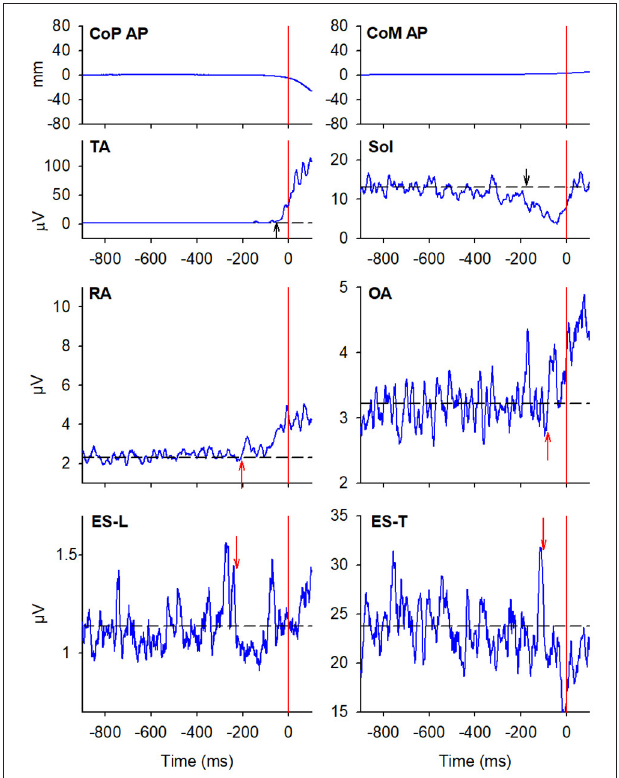
FIGURE 2 | The two uppermost plots display the AP displacements of CoP and center of mass (CoM) in a representative subject when starting gait. Vertical red lines at time 0 mark the onset of the backward CoP shift. The remaining plots show the EMG activity recorded in the prime movers Tibialis Anterior (TA) and Soleus (Sol), as well as in trunk postural muscles Rectus Abdominis (RA), Obliquus Abdominis (OA), Erector Spinae at L2 vertebra (ES-L), and Erector Spinae at T3 (ES-T) of the leading side (right). Arrows in each EMG plot mark the onset of excitation (upward arrow) or inhibition (downward arrow). Black dashed lines represent the average muscle activity in the baseline time window.